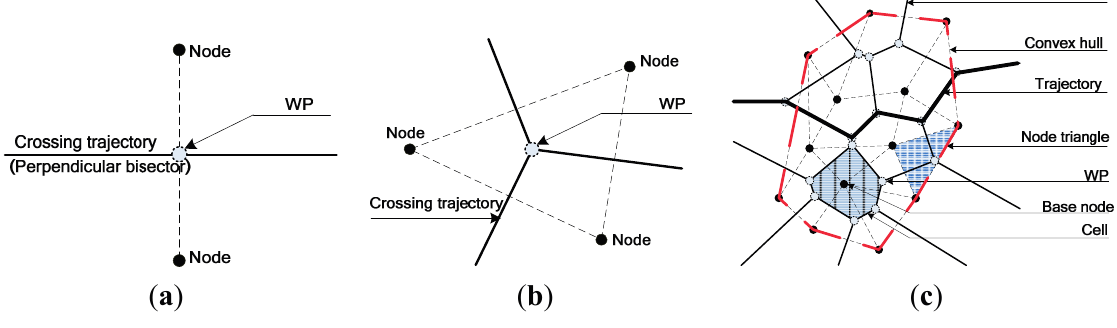
Figure 1. Coverage force division for different uniform nodes. ( a ) Two nodes; ( b ) Three nodes; ( c ) More than three